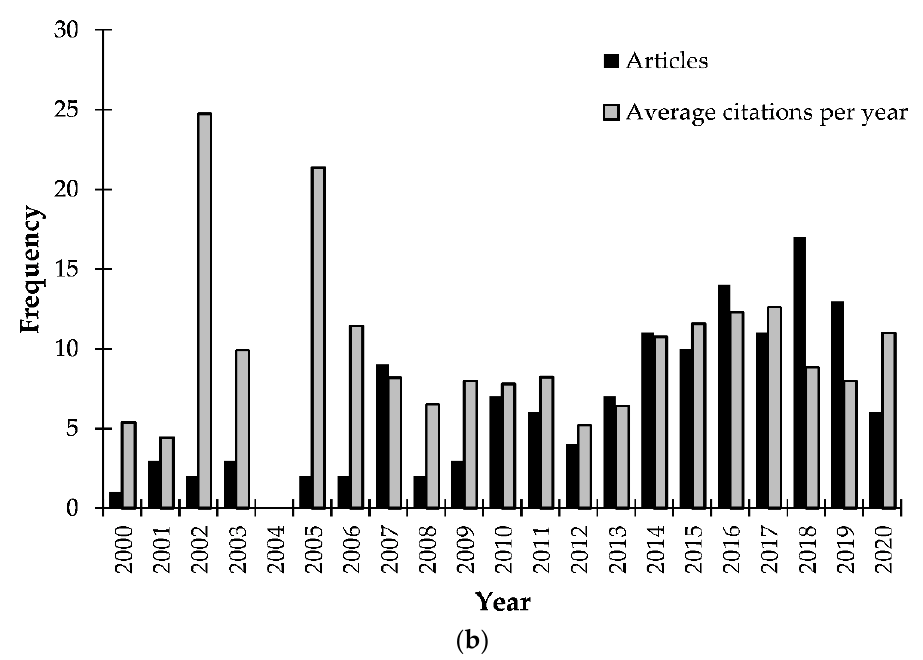
Figure 2. ( a ) Source trends for top 4 journals by number of documents (Table 2). ( b ) Trends in scientific production depicted by the number of articles and average citations per year.